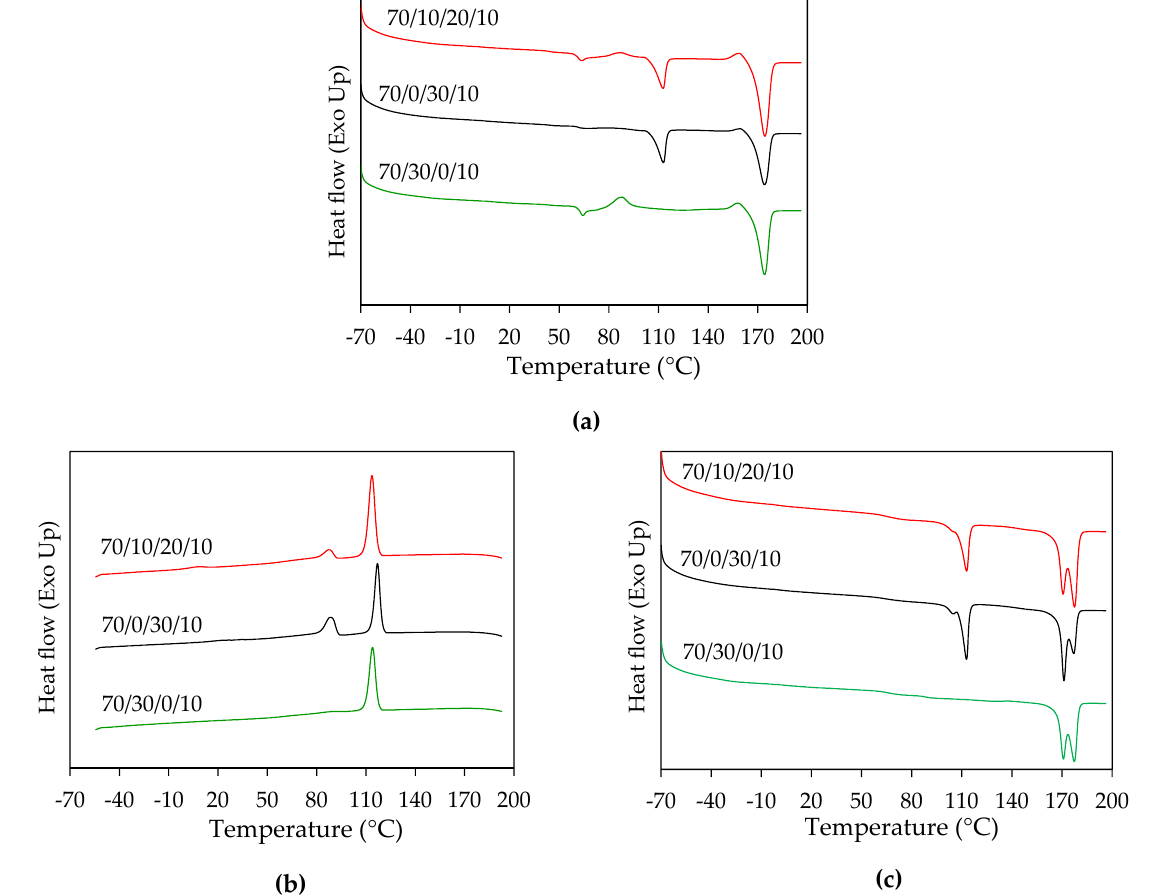
Figure 2. DSC thermograms of PLA/PBAT/PBS nano talc composite 3D prints: ( a ) First heating cycle; ( b ) Cooling cycle; ( c ) Second heating cycle. Table 3. Thermal properties and crystallinity of neat polymers and PLA/PBAT/PBS/nano talc composite 3D prints.